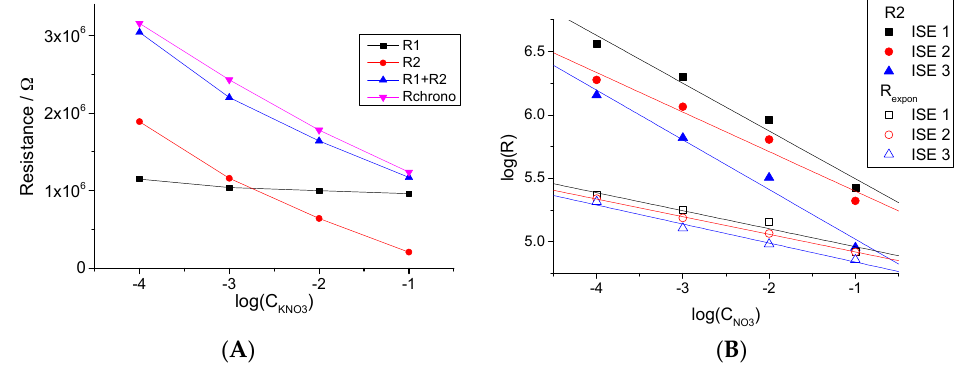
Figure 6. ( A ) Resistances R1, R2, R chrono , and the sum of R1 + R2 obtained with ISE 2; ( B ) dependence of R2 and R expon on the KNO 3 concentration in the solution for all ISEs under study.